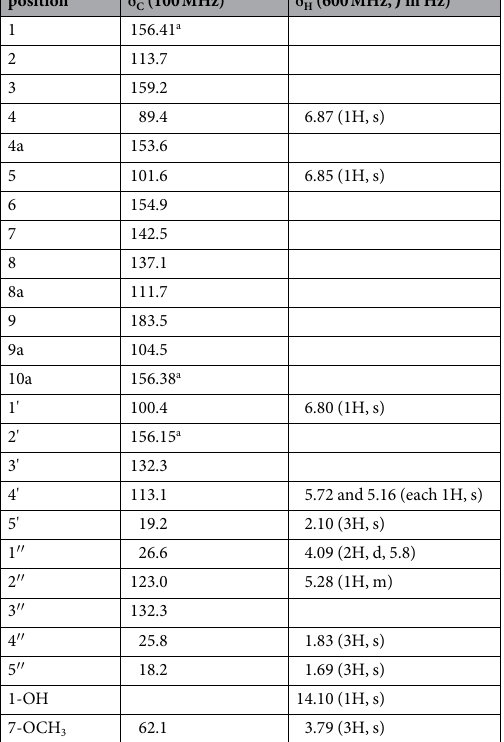
Table 1. 1 H and 13 C NMR Spectroscopic Data of 12 in CDCl 3 . a These may be